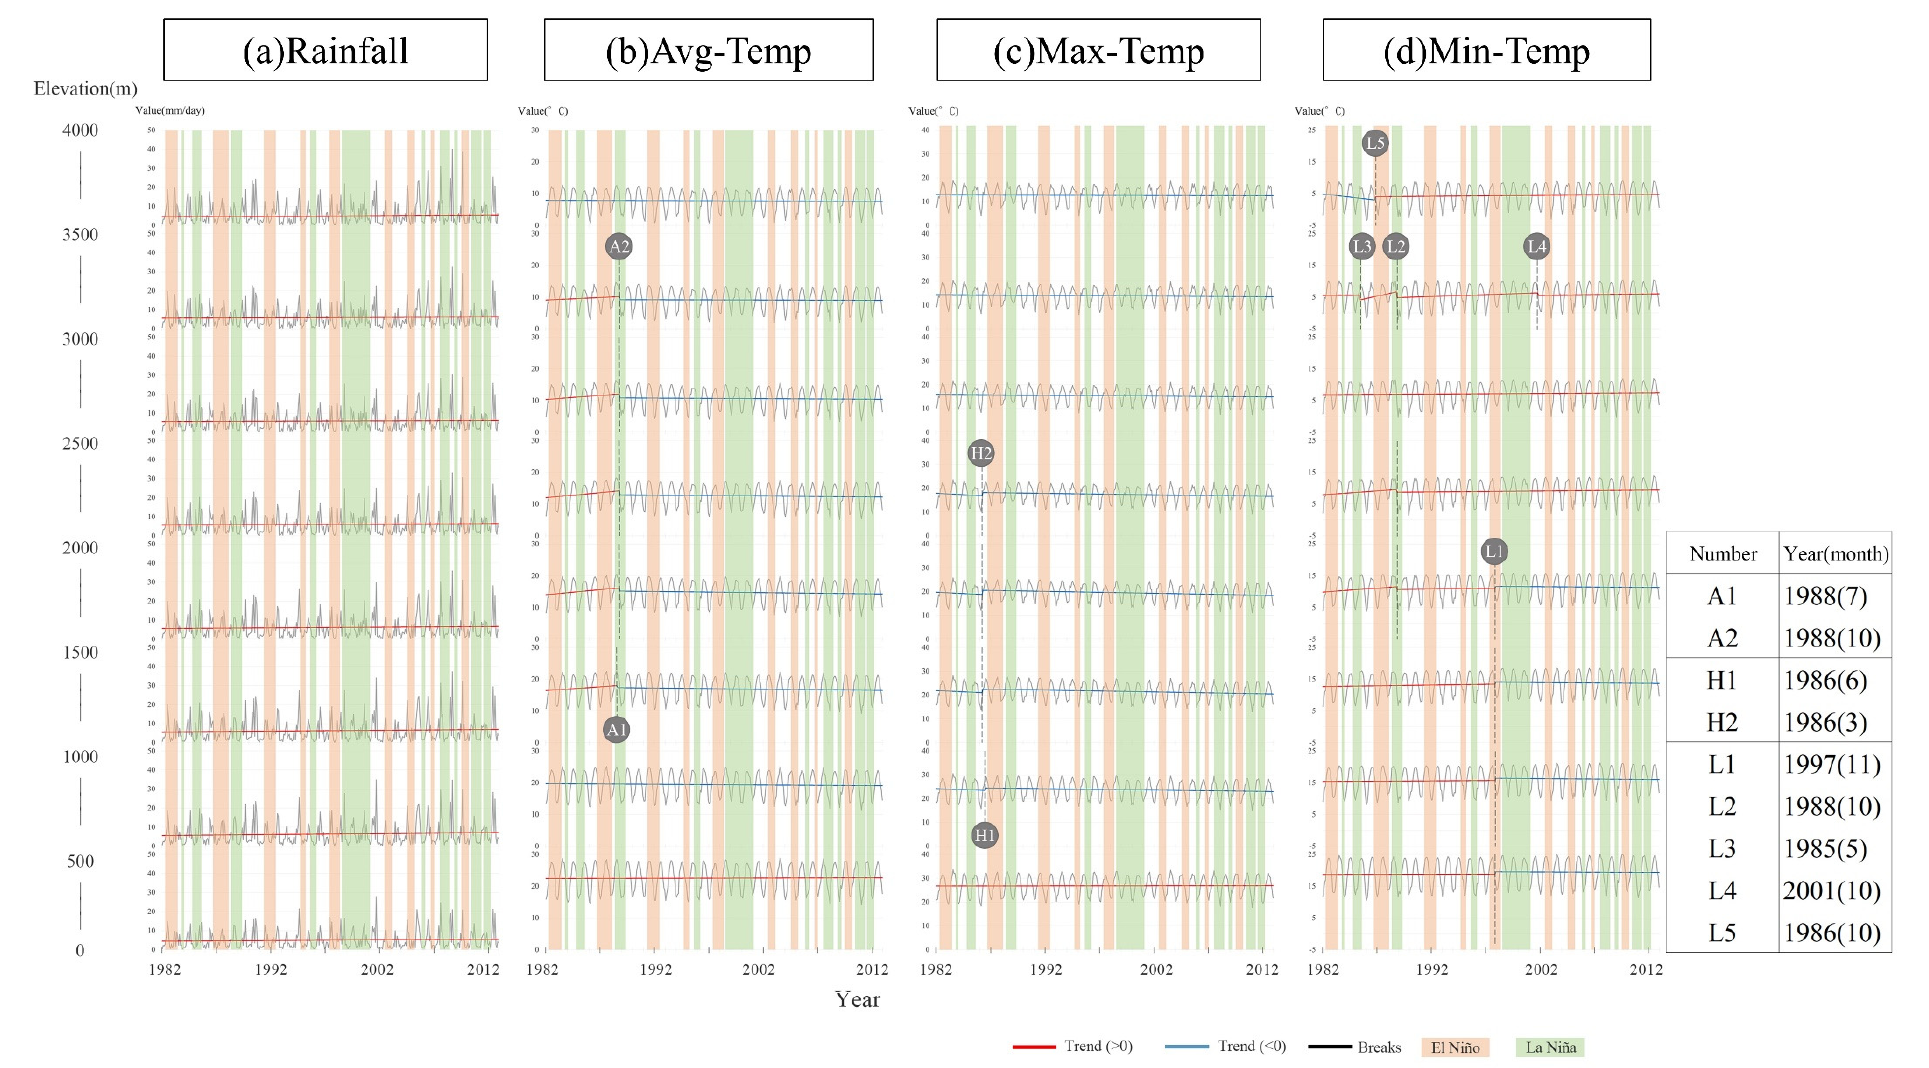
Figure 5. BFAST results for ( a ) rainfall, ( b ) average temperature, ( c ) maximum temperature, and ( d ) minimum temperature in Taiwan, at varied elevations.